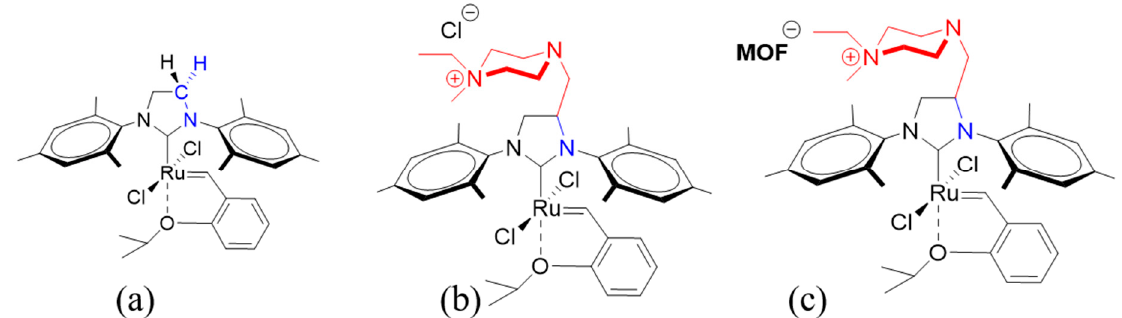
Scheme 1. Three-dimensional (3D) Lewis structure of the olefin metathesis catalysts studied: